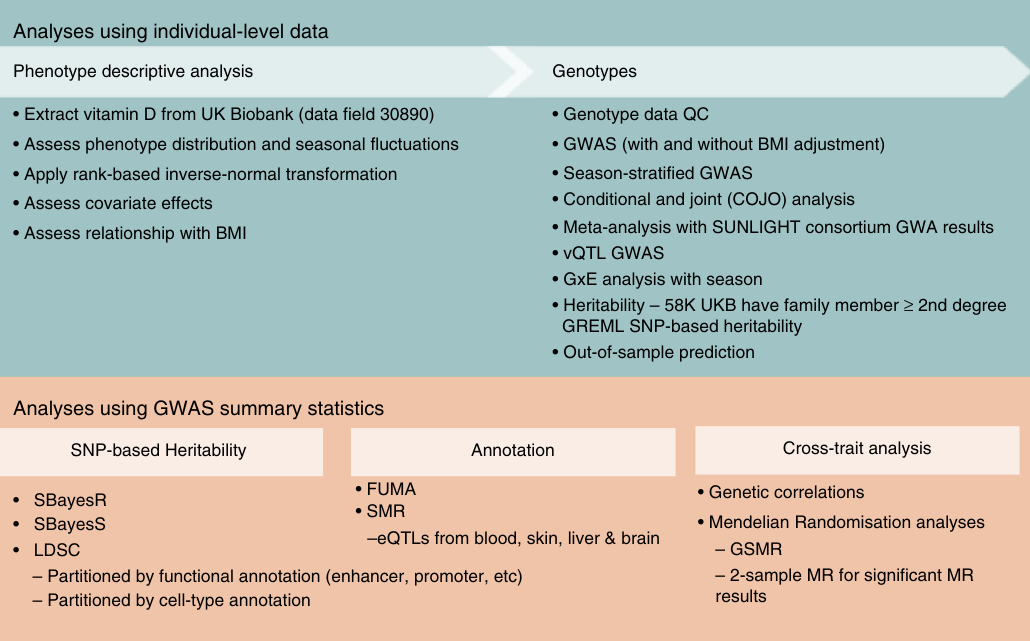
Fig. 1 Outline of key analytic steps described in this study. BMI body mass index, eQTL expression quantitative trait locus, FUMA functional mapping and annotation 23 , GREML 69 genomic relationship restricted maximum likelihood 68 , GSMR generalised summary-based MR, GWAS genome-wide association study, GxE genotype-by-environment interaction, LDSC linkage disequilibrium score regression, MR Mendelian Randomisation, SMR summary-based MR 26 , QC quality control, UKB UK Biobank, vQTL variance quantitative trait locus 12 .